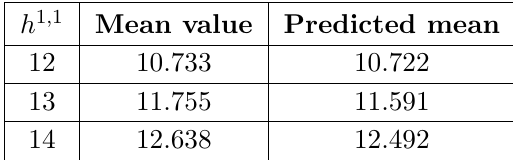
Table 5 . The true mean values and the mean predicted by our model in the extrapolation region.